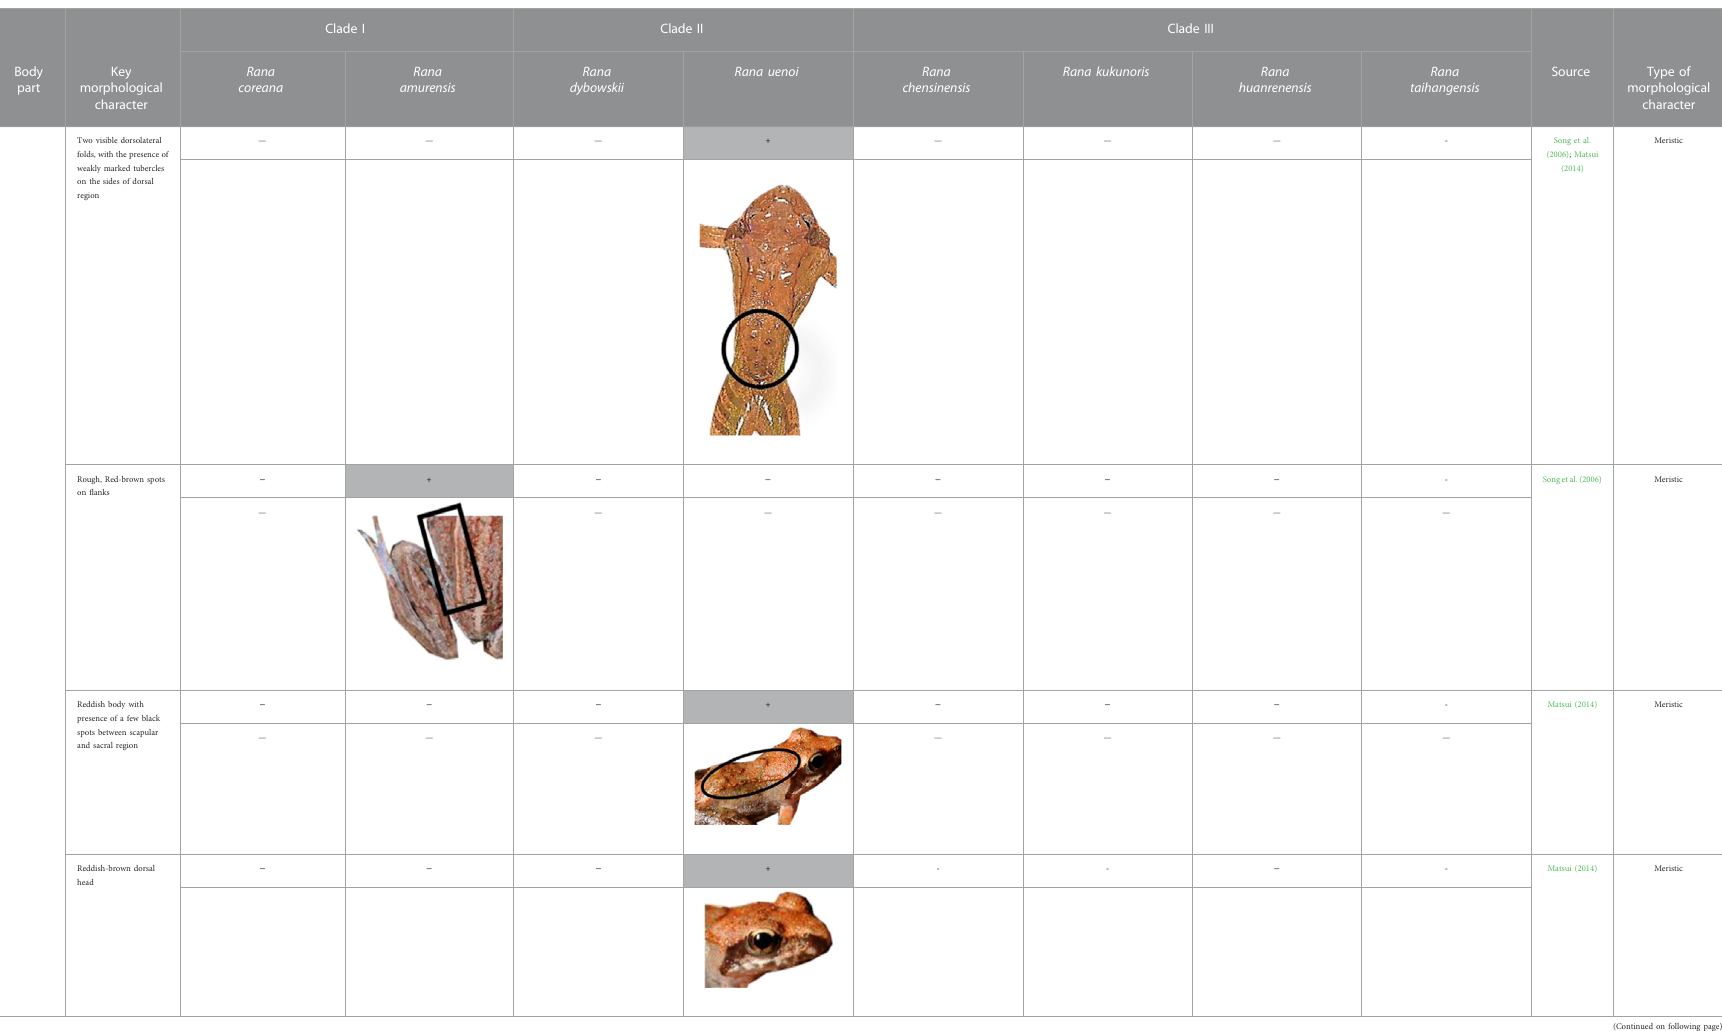
boxes marked with symbol ( − ) indicate the absence of the character in the species, OR, the absence of de fi nitive information but matching with at least a few individuals of the species. The symbol (?) indicate the lack of information about the speci fi c morphological character. Coloration outside of the breeding season is not speci fi ed as the trade is limited to the breeding season when body condition makes frogs more suitable for human consumption. The comparison of morphological characters and classi fi cations of Rana into clades I, II and III in the table are adapted from the operational taxonomic units (OTU) based on the 16S rRNA phylogeny of Othman et al. (2022), where R. chensinensis matches with OTU 7 and R. taihangensis matches with OTU 1 and 2, following Shen et al.